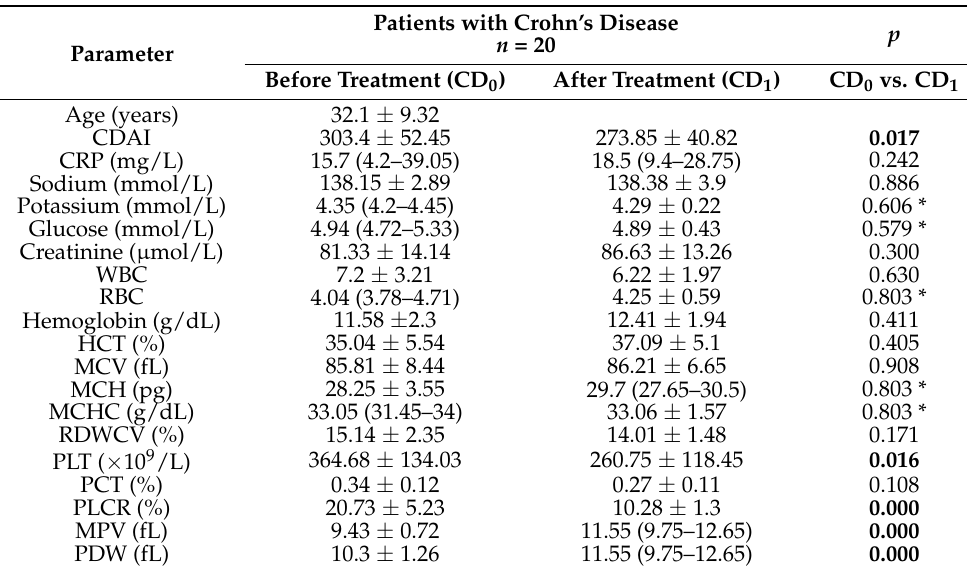
Table 2. Clinical characteristic of patients with Crohn’s disease (CD) before and after a year of anti-inflammatory